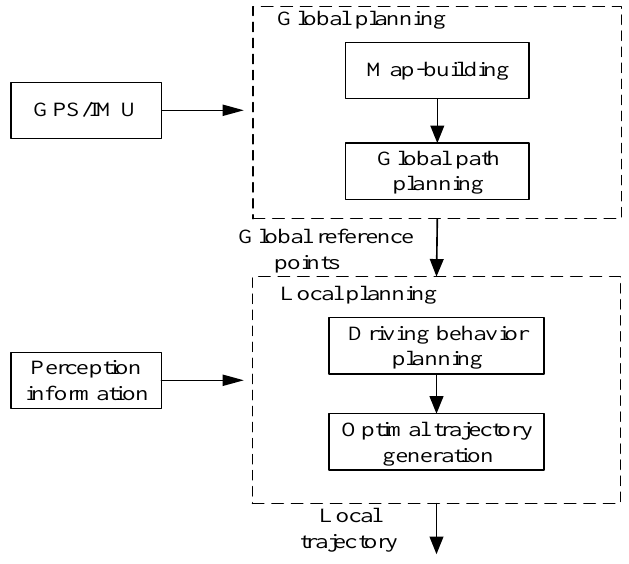
Figure 1. Framework of path planning for autonomous bus.